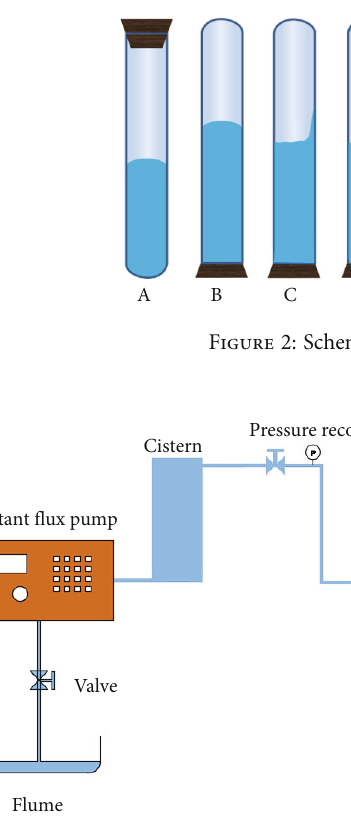
Figure 3: Diagram of the experimental device for core